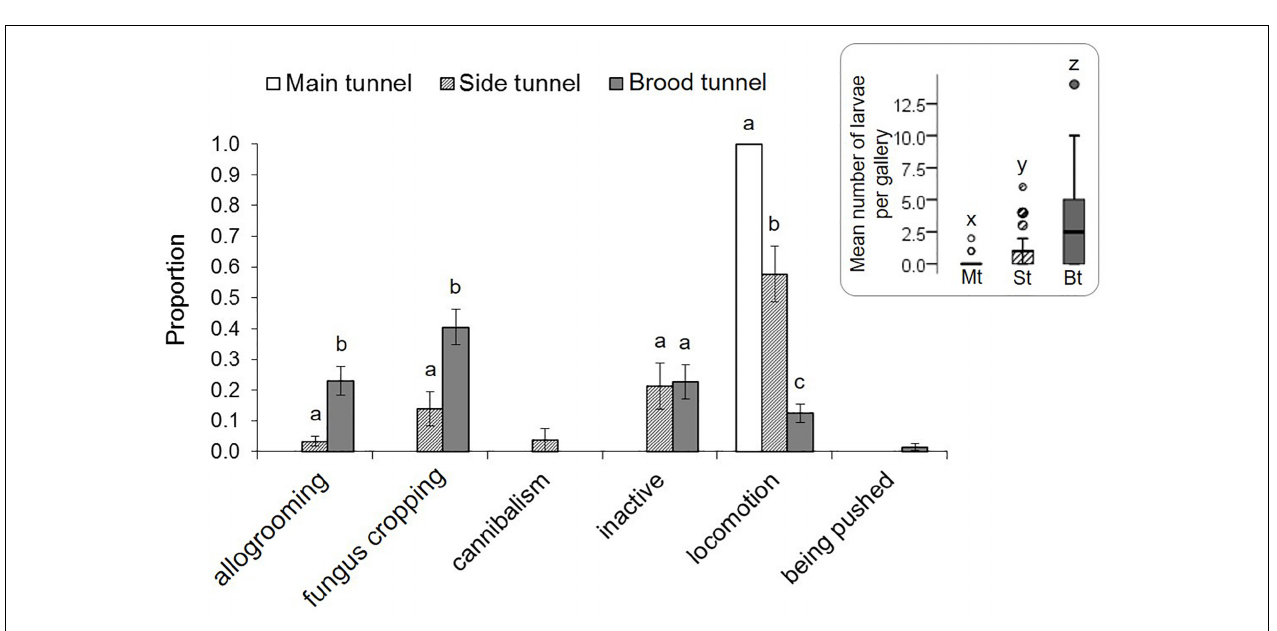
FIGURE 2 | Reproductive status in relation to adult female behavior. All females engage in mutually beneficial behaviors. However, relative to selfish behaviors, females with fully developed or egg-carrying ovaries ( potential breeders ) tended to engage more often in mutually beneficial behaviors (see Table 1 ) than females with non-developed ovaries ( non-egg-layers ) (Fisher’s exact test: p = 0.085, N = 21).